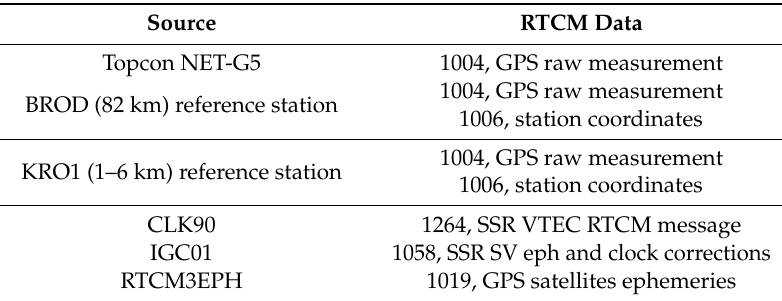
Table 1. RTCM streams recorded during the test drive.